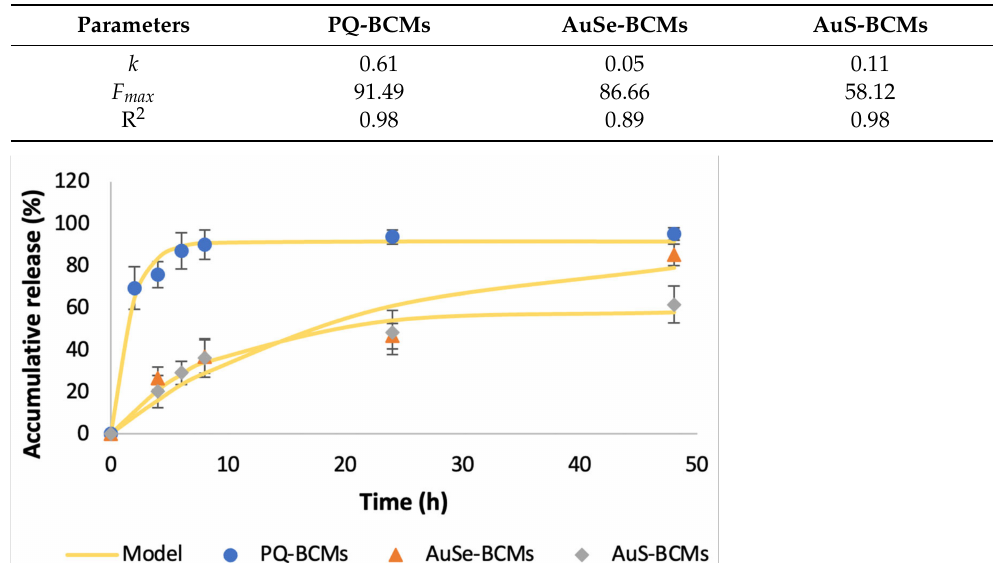
Table 3. Parameters and goodness of fit exhibited by the first-order model used to fit the fraction of the accumulated drug release ( F % ) as a function of time.